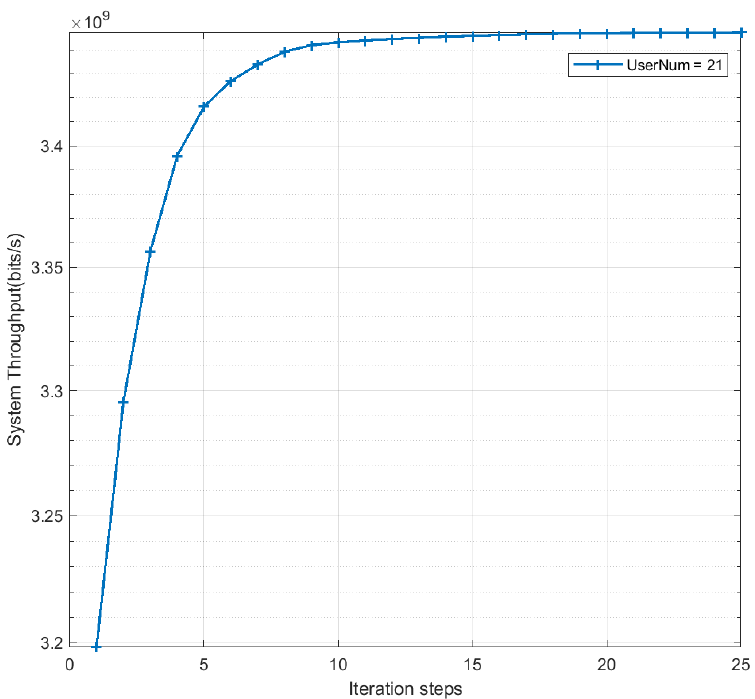
Figure 7. Convergence behavior for the system throughput using Algorithm 2, where N t = 4, N r = 16.